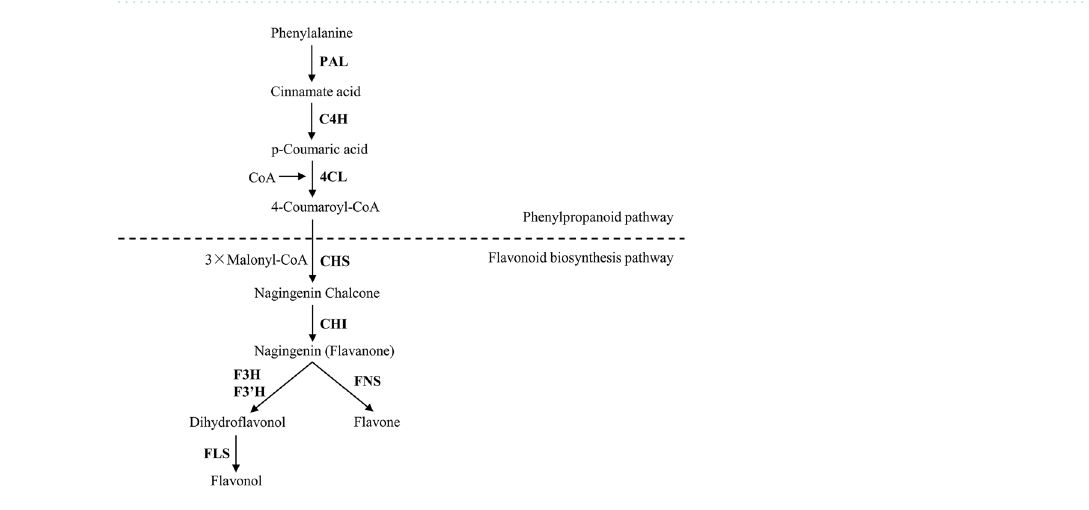
Figure 10. The flavonoid biosynthetic pathway in Herba Epimedii . Bold words indicate the key enzymes in flavonoid